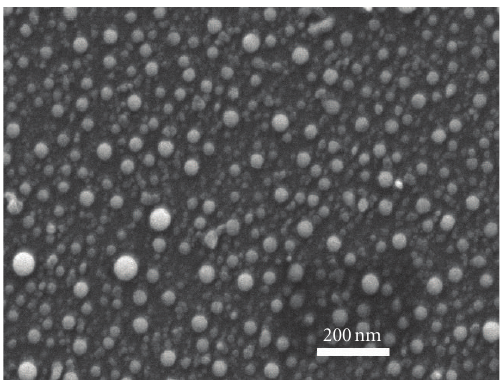
Figure 4: Gold islands after annealing of 10 nm Au layer over fused silica.